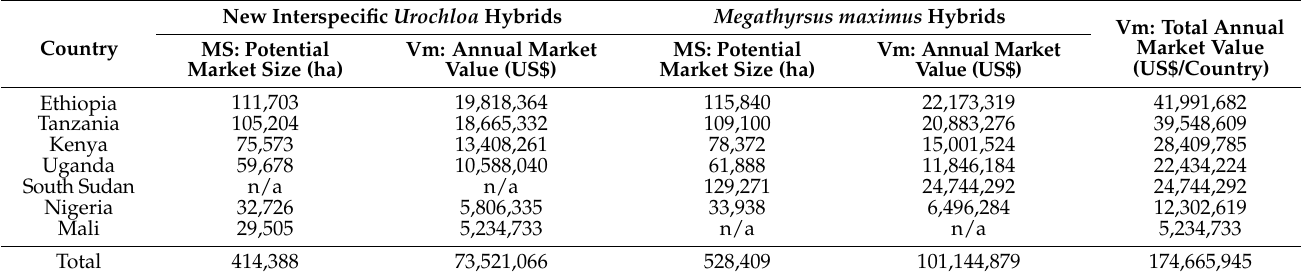
Table 5. Summary of potential market sizes and values for new forage hybrids in